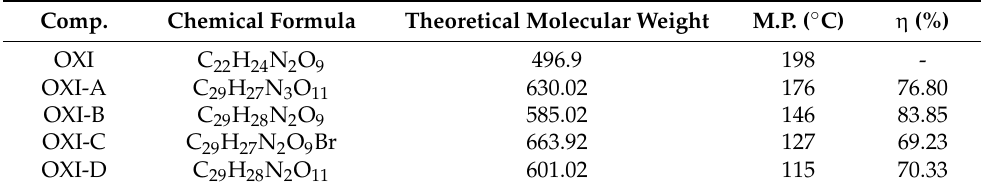
Table 2. Physico-chemical properties of oxytetracycline derivatives.